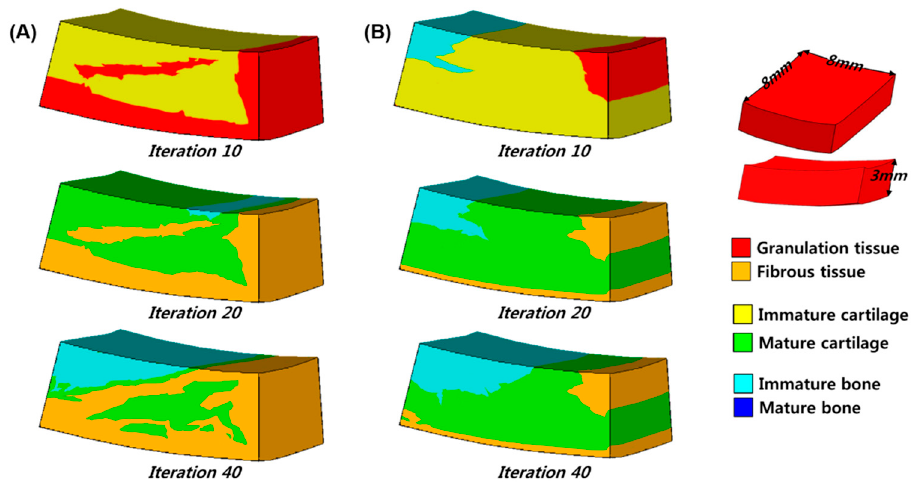
Figure 5. Pattern of regeneration of the cartilage defect in the knee joint model in 10, 20 and 40 iterations for ( a ) axial and ( b ) stance-phase gait cycle loading.